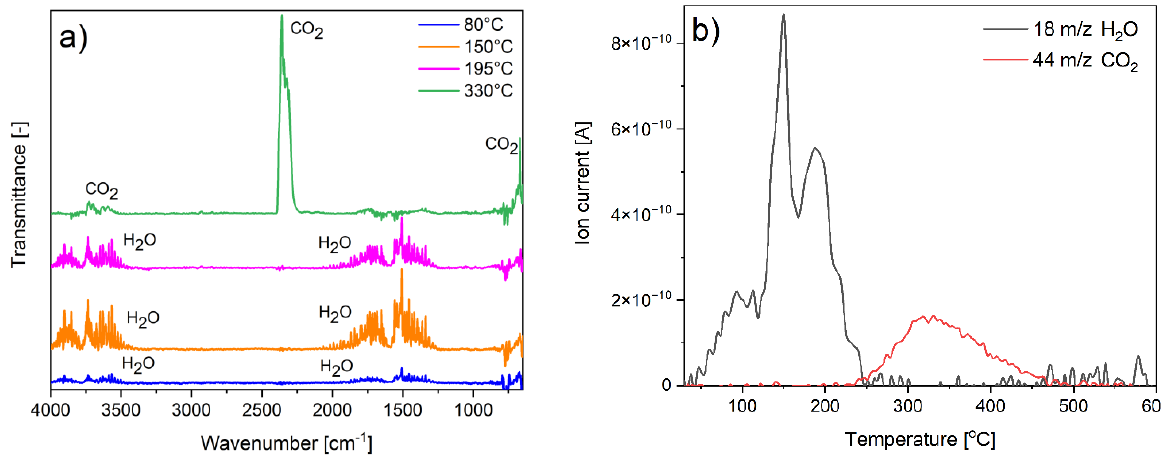
Figure 6. Spectra of evolving gaseous products: ( a ) FTIR; ( b ) QMS.